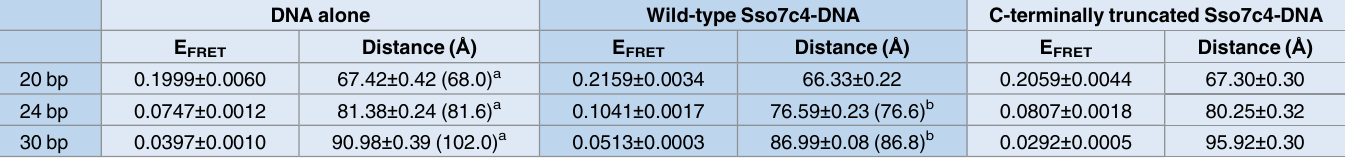
Table 3. FRET efficiency and distance of the DNA duplex alone or bound to Sso7c4 in bulk FRET experiments. DNA alone